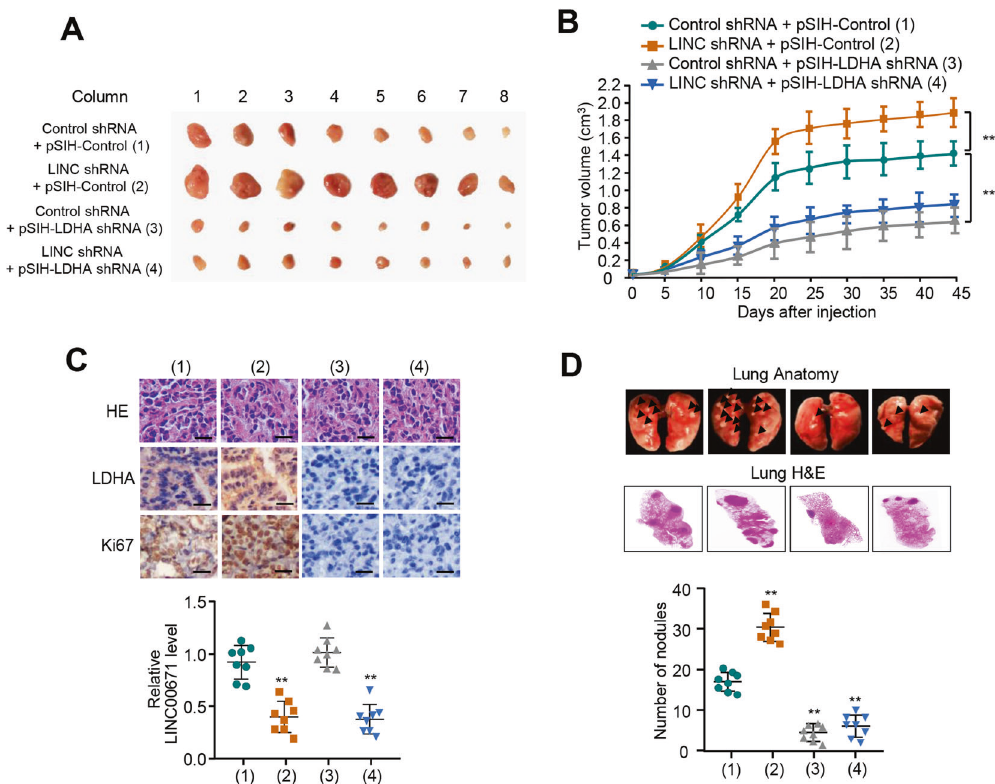
Fig. 6 LINC00671/LDHA axis regulates TC tumor growth and lung metastasis in vivo. A , B TPC-1 cells stably infected with the lentivirus carrying the indicated constructs were injected subcutaneously into nude mice ( n = 8 per group). The tumor volume was measured every 5 days and the growth curve was plotted ( B ). C Representative IHC staining of LDHA, Ki67, and H&E images of tumors resected from ( A ). Scale bar, 50 µm. The scattered plot shows the expression levels of LINC00671 measured by qRT-PCR. D TPC-1 cells stably expressing the constructs were injected through the tail vein to establish a thyroid cancer cell metastasis model in nude mice ( n = 8 per group). Anatomical and histological analyses of representative lung metastases were performed. The number of tumor nodules was observed under the anatomical microscope. Symbols represent individual mice. ** P < 0.01 versus the corresponding